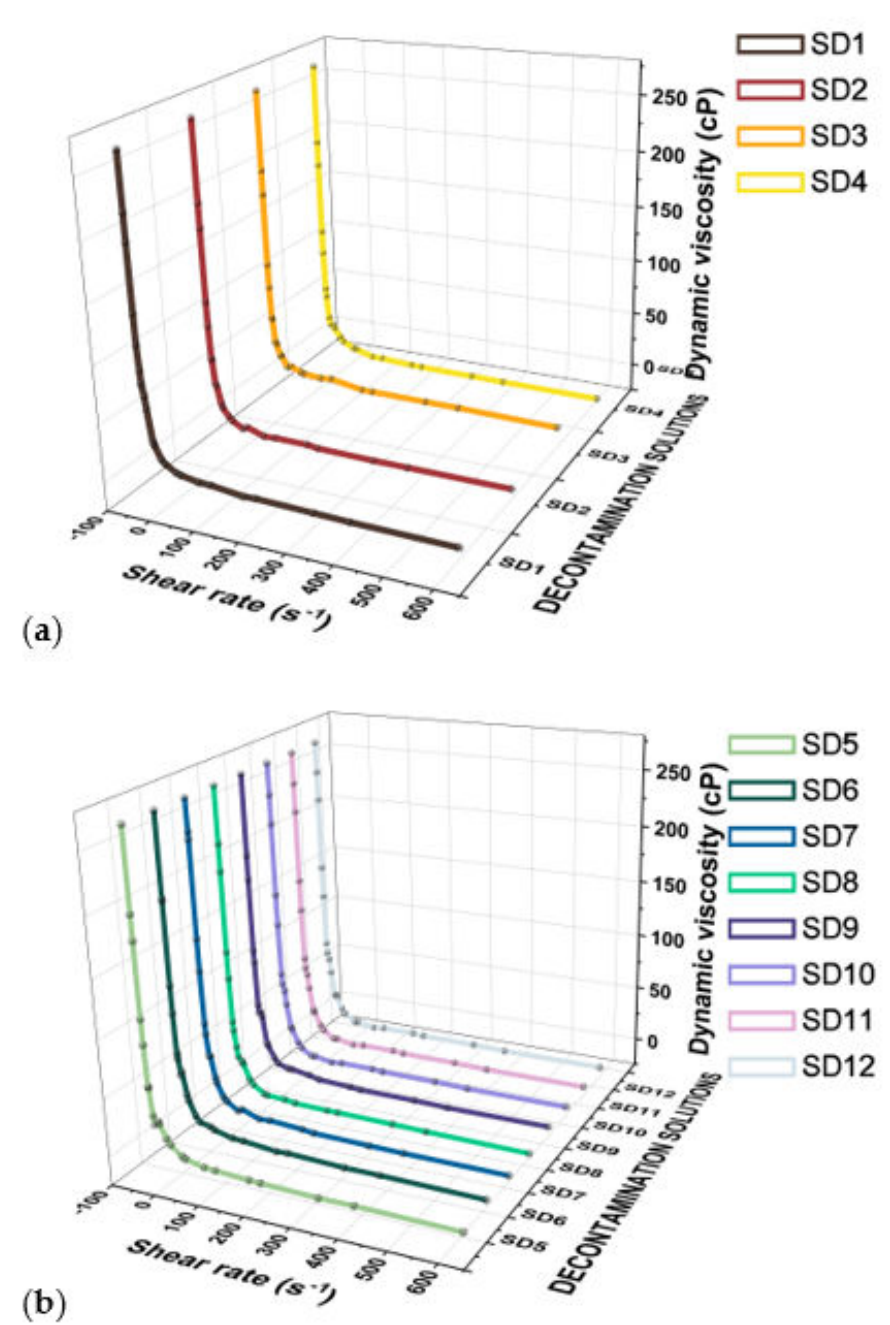
Figure 2. Variation of the dynamic viscosity with shear rate for the decontamination